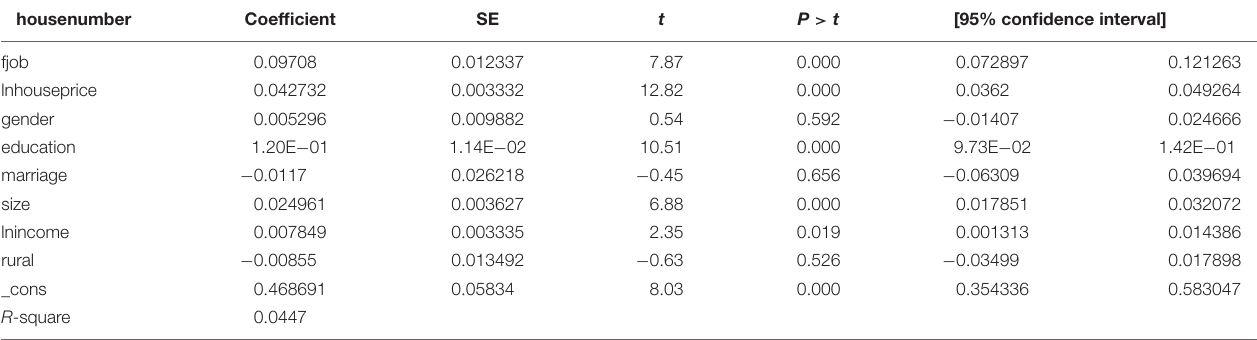
TABLE 4 | The ivprobit regression results of the first stage. housenumber